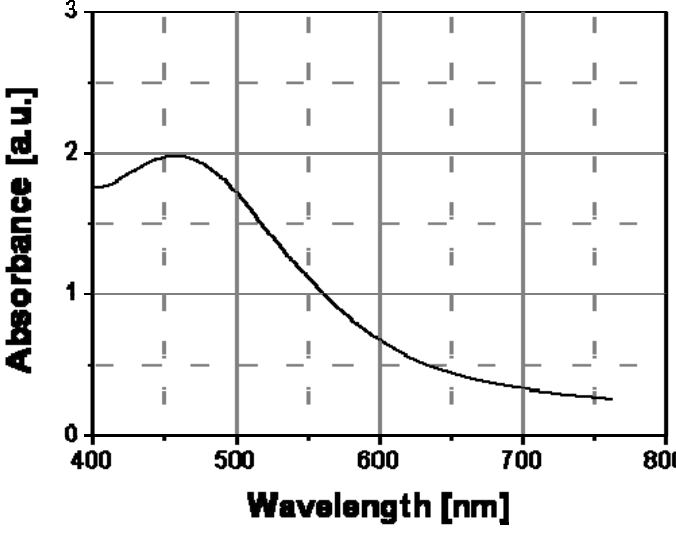
Figure 13. Optical absorption spectrum of cyclohexyl-thiolate capped silver nanoparticles embedded into an amorphous polystyrene